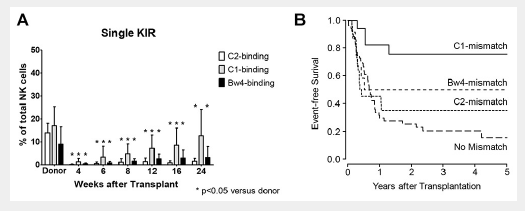
Temporal evolution of the frequencies single KIR expressing NK cells as percentage of total NK cells shows a skewed repertoire with slow reconstitution of single KIR expressing subsets. Reconstitution is fastest for C1-binding KIR, followed by Bw4 binding KIR and C1-binding KIR. This is mirrored in survival curves of patients stratified by type of KIR ligand mismatch, with best survival seen in patients transplanted from a donor KIR ligand mismatched for a receptor that reconstitutes early after transplantation (adapted from Stern M, de Angelis C, Urbani E, Mancusi A, Aversa F, Velardi A, L Ruggeri L. Natural killer-cell KIR repertoire reconstitution after haploidentical SCT. Bone Marrow Transplantation.